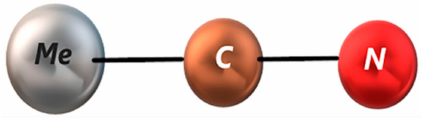
Figure 1. Molecular model of